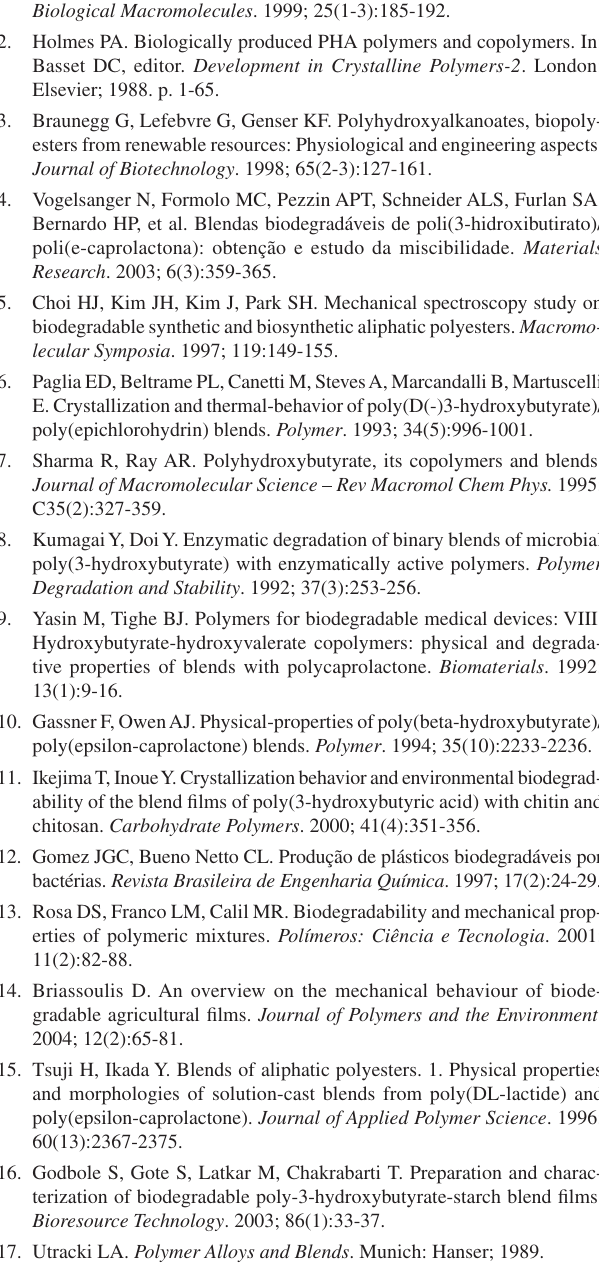
) and maximum degradation i